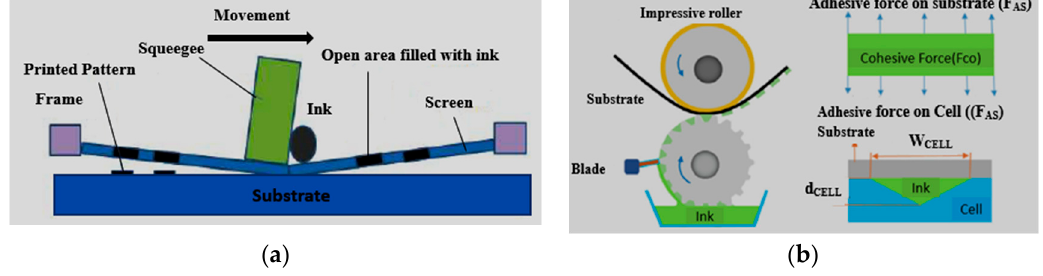
Figure 4. ( a ) Fabrication process for multilayer fabrication [177], and ( b ) gravure printing